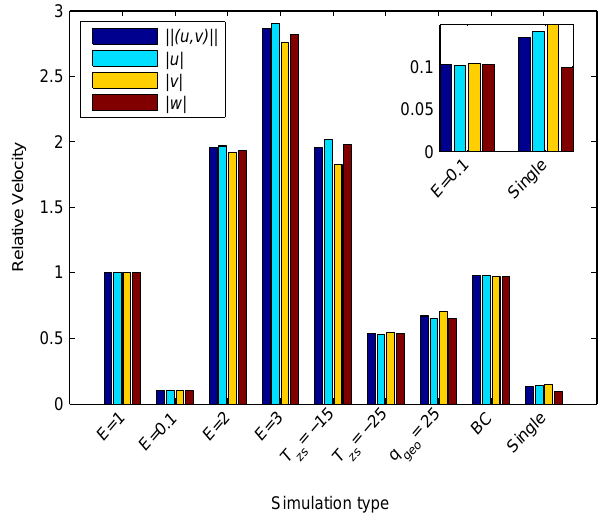
Fig. 3. Summary statistics showing how component magnitudes of the velocity vector u = (u,v,w) T averaged over the inner BIA field are affected by changes in simulation parameters relative to the values in a standard simulation. Values are relative to simulations using an isotropic flow law (5); enhancement factor, E = 1; sur- face temperature, T zs = − 20 ◦ C; and geothermal heat flux, q geo = 60mWm − 2 (leftmost four columns). The other column sets rep- resent results from simulations with a single parameter varying from this standard configuration as denoted by labels beneath the columns. BC represents a simulation with no inflow, u = 0, on the otherwise free inflow boundary of the domain. The rightmost set contains the results for the single maximum fabric simulation, and the inset emphasizes differences in horizontal and vertical compo- nents between this case and the isotropic case with the reduced en- hancement factor ( E = 0 .